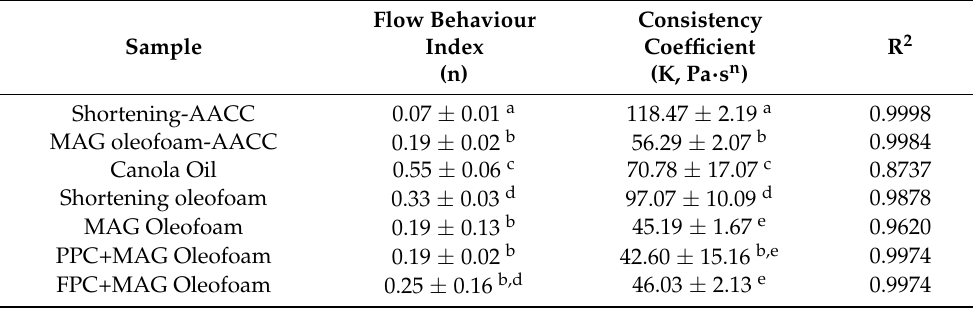
Table 2. Effect of replacement of shortening by different oleofoams on power-law parameters of different cake batters. The batters were prepared with shortening or MAG-oleofoam using the AACC method or with different oleofoams using a lab-developed method. Different letters in each column indicate a statistically significant difference ( p <